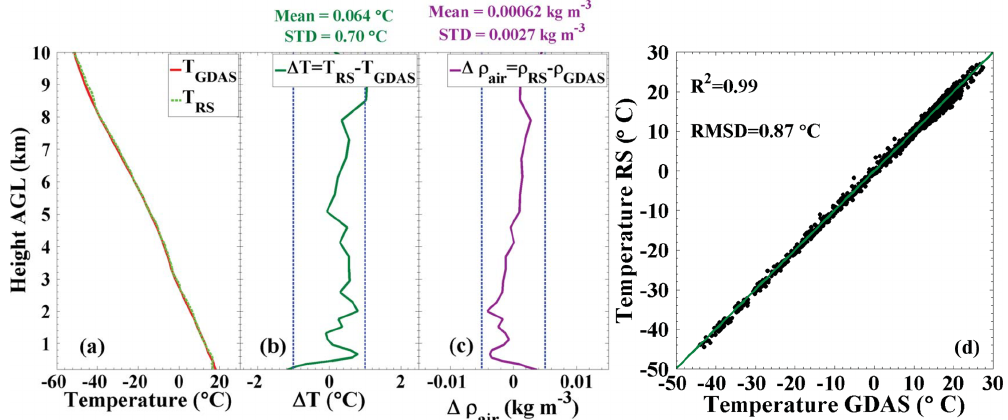
Figure 3. (a) Comparison of temperature profiles from the GDAS database and radiosonde observations; (b) the difference between the two temperature values; (c) the respective difference between the dry air density retrieved from GDAS data and from the radiosonde observation measured on 15 April 2017; and (d) the correlation of temperature values from all 43 radiosondes and simultaneous GDAS estimations at the grid point 34.5 ◦ N, 33 ◦